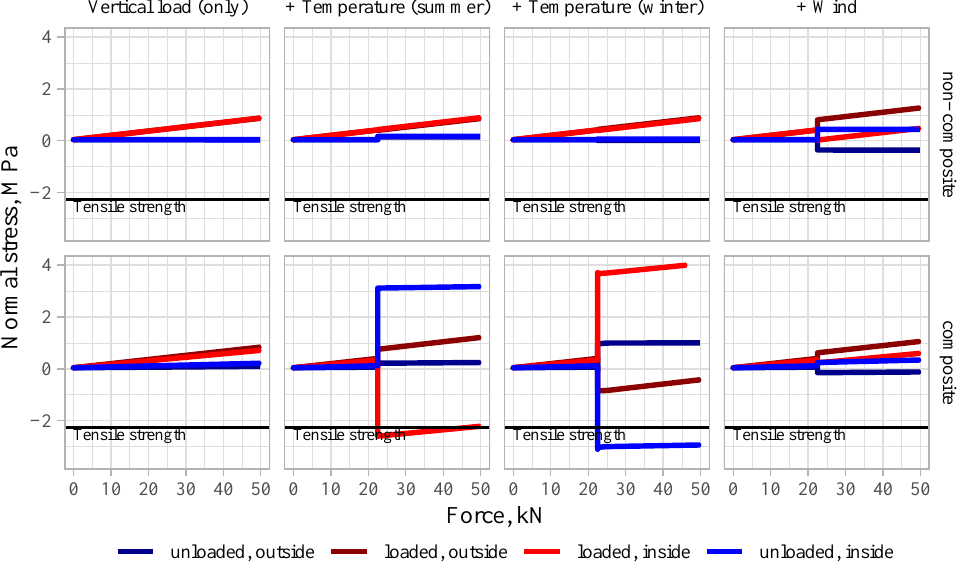
Figure 18. Stress on the surfaces of the wythes half-way up the wall in the range of loads from 0 to 50